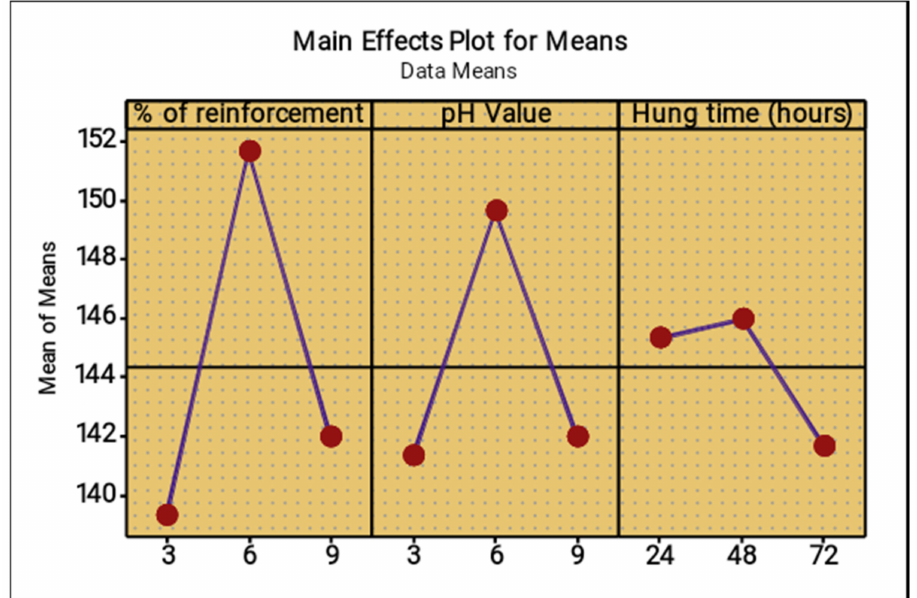
Figure 31. Main effect plot for means